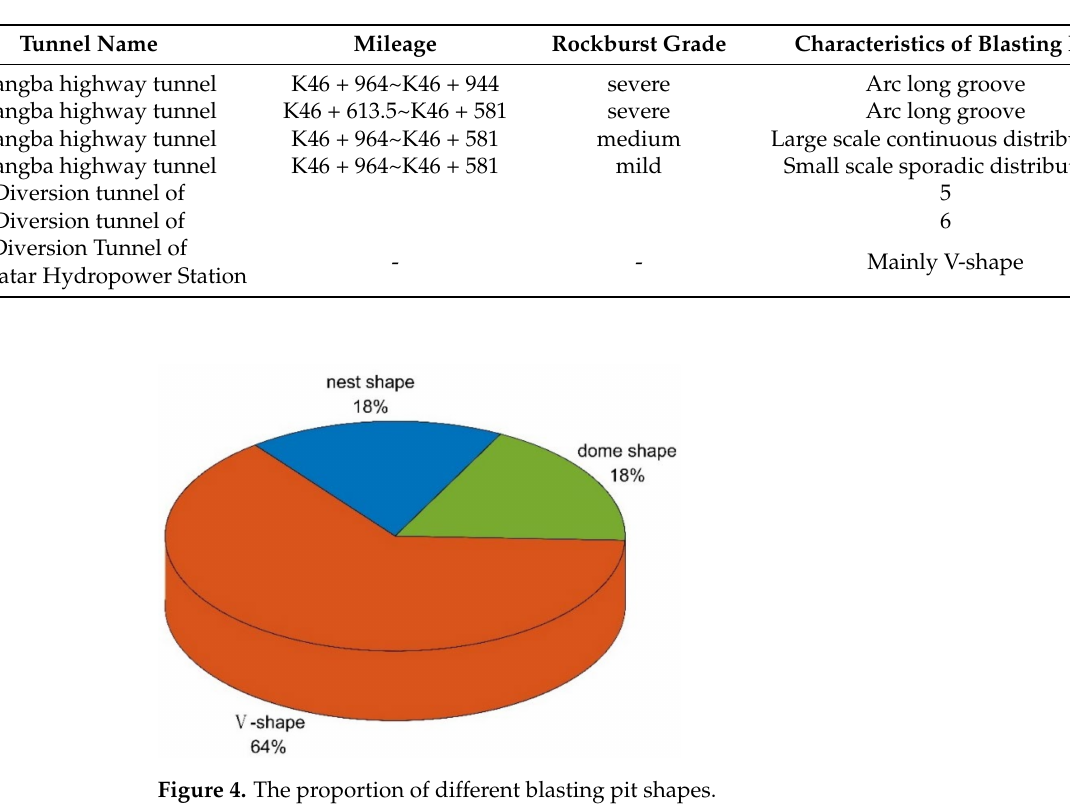
Table 2. Statistics of craters of different rockburst tunnels.